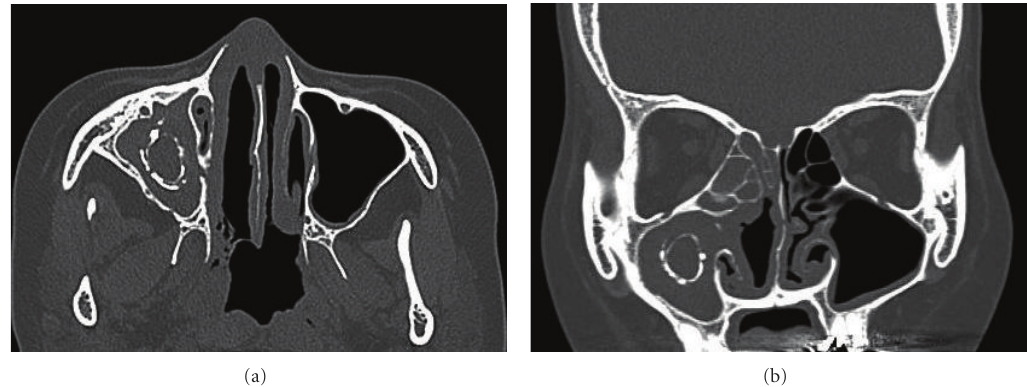
Figure 1: Horizontal (a) and axial (b) CT image. Ring-like calcification is seen in the right maxillary sinus.